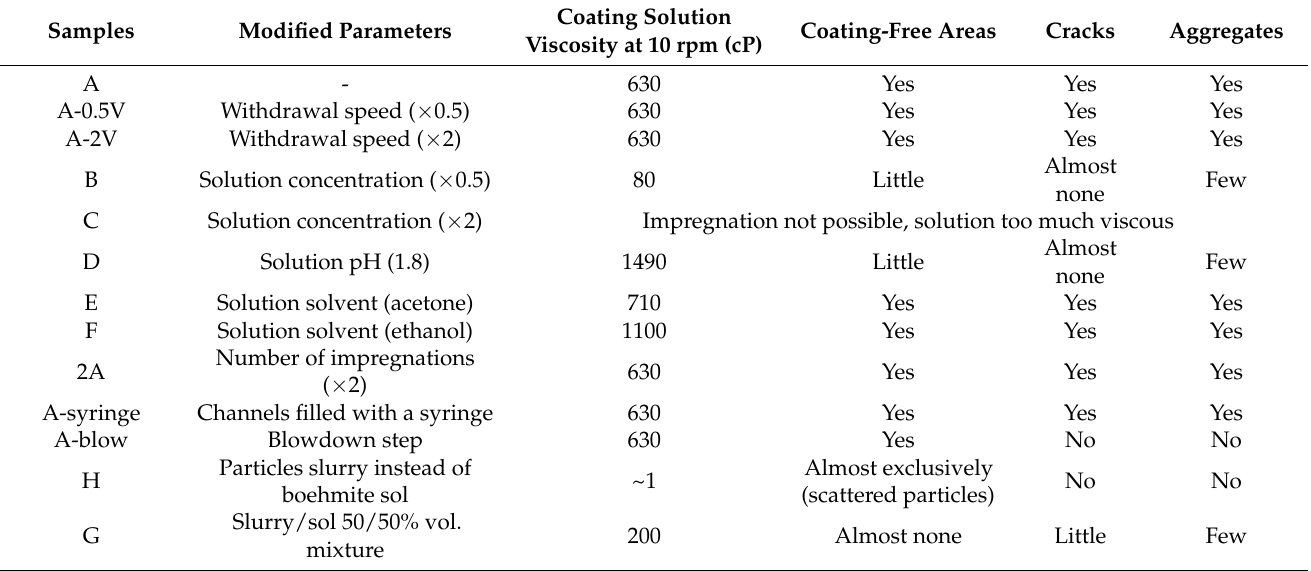
Table 3. Coated samples, related coating method and observed defects on dried